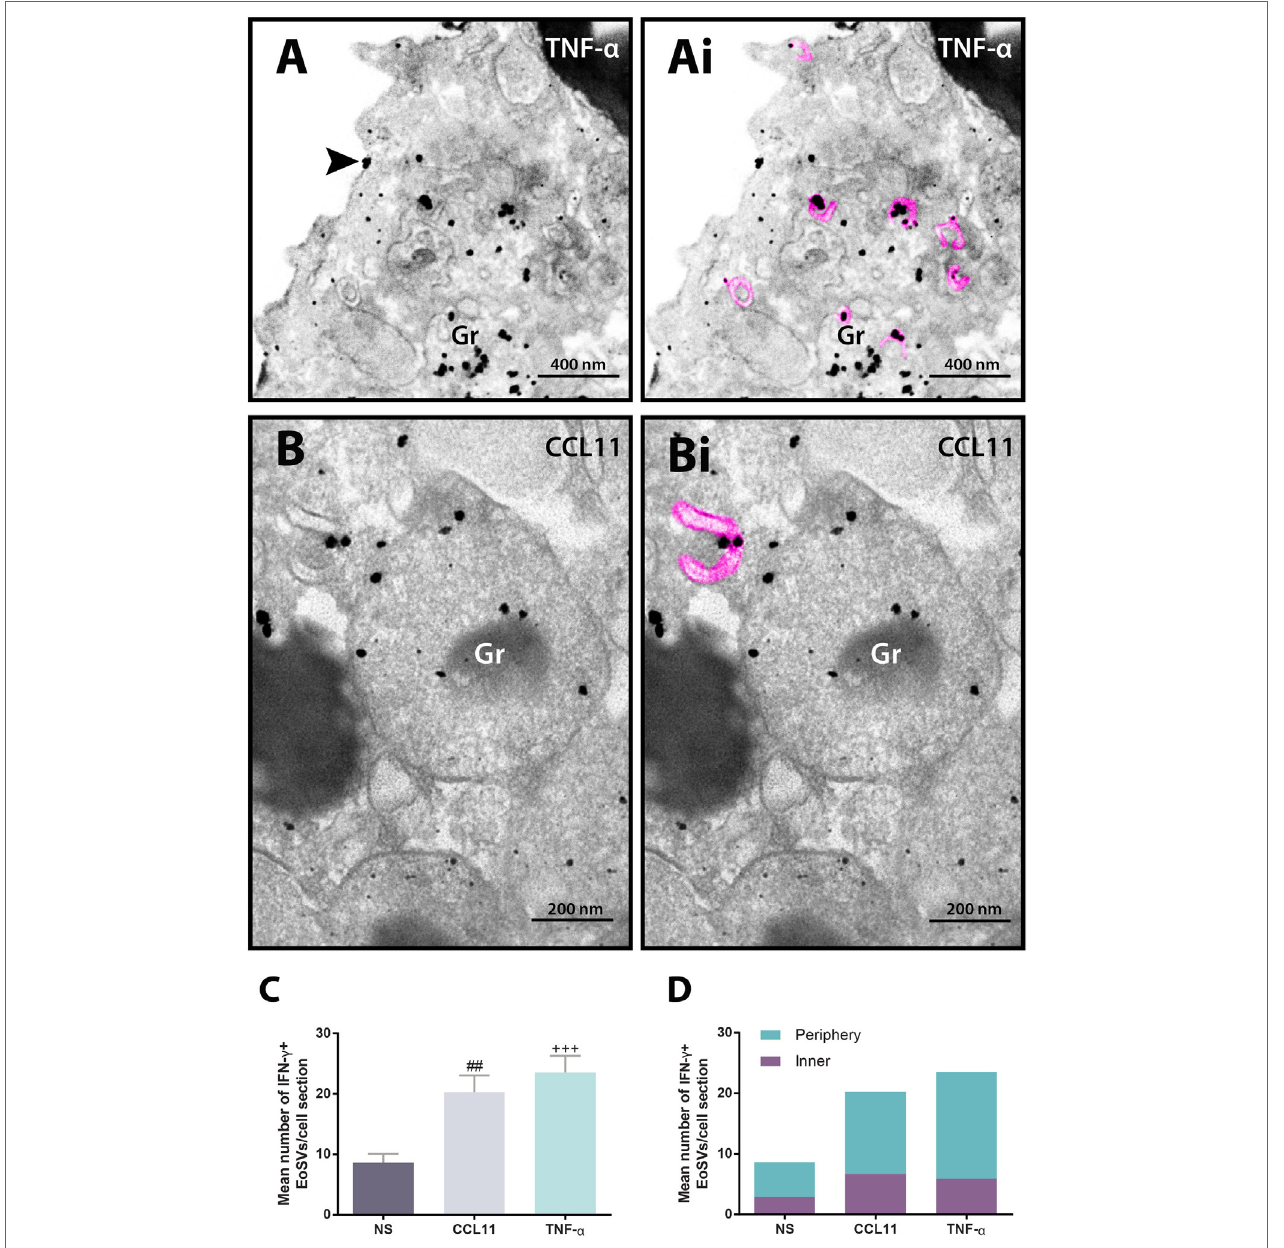
FigUre 4 | Vesicular trafficking of IFN- γ in the cytoplasm of human eosinophils. IFN- γ -positive Eosinophil Sombrero Vesicles (EoSVs) [highlighted in pink in (ai) and (Bi) ] are seen in activated cells after stimulation with tumor necrosis factor alpha (TNF- α ) (a) or CCL11 (B) . Note that labeling is mostly associated with the vesicle membranes. EoSVs carrying IFN- γ are distributed in the peripheral cytoplasm (a) and in close association with secretory granules (Gr) undergoing release of their contents (a,B) . (c) After stimulation, the total numbers of IFN- γ -positive EoSVs significantly increased. (D) Most EoSVs immunolabeled for IFN- γ were observed in the cell periphery. Arrowhead in (a) indicates extracellular release of IFN- γ . Data represent mean ± SEM. NS, not stimulated. The numbers of labeled and not labeled EoSVs ( n = 1,357 vesicles) were counted in cell sections ( n = 30). ## P = 0.0051 versus NS group; +++ P = 0.0004 versus NS group. Cells were isolated from the peripheral blood, stimulated or not with CCL11 or TNF- α , and prepared for pre-embedding immunanogold